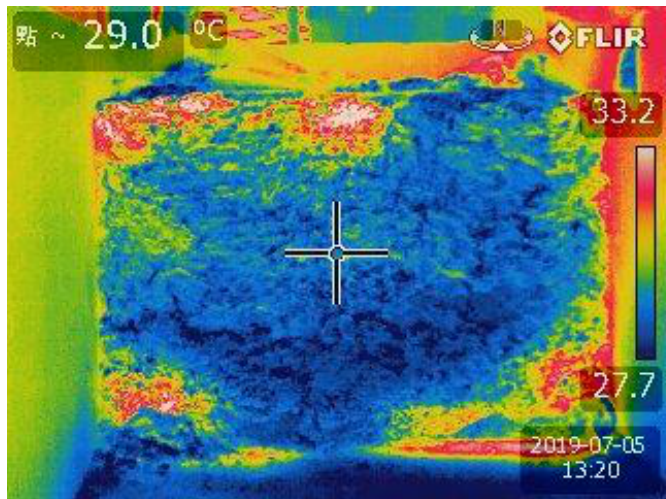
Figure 5. Thermogram of corn silage after 105-d storage. Corn silage was treated without (left-half)